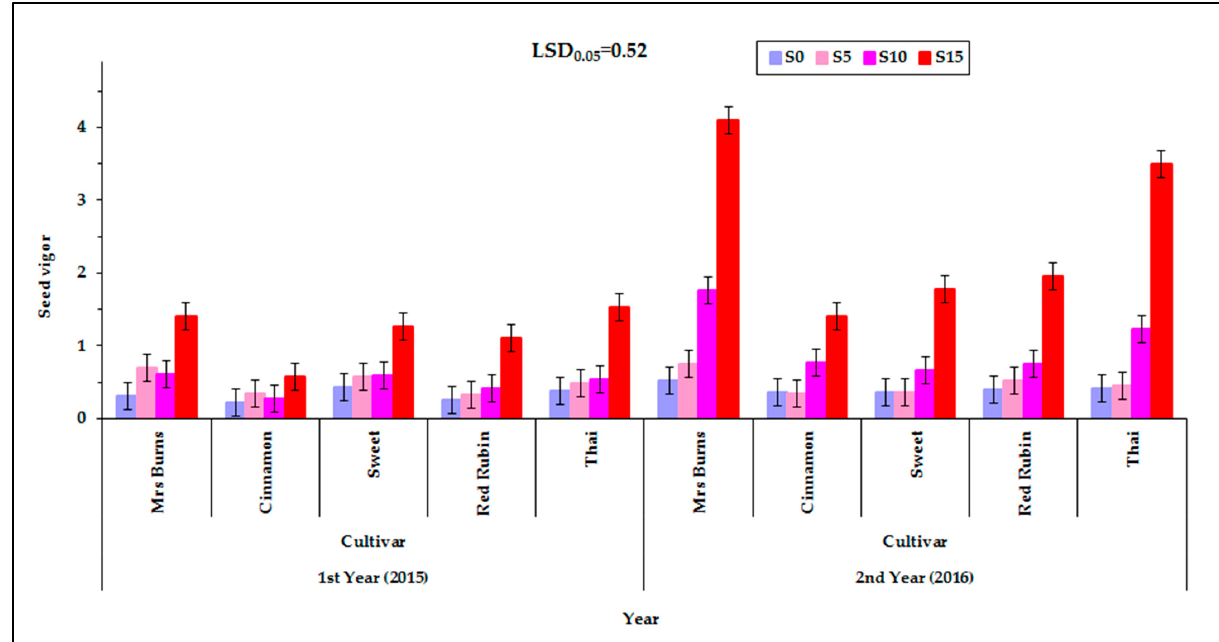
Figure 10. Seed vigor of the five basil cultivars (“Mrs Burns”, “Cinnamon”, “Sweet”, “Red Rubin”, and “Thai”), at the four PEG concentrations (S 0 , S 5 , S 10 , and S 15 ) at the two years of experimentation. Data presented are estimated mean values averaged over the three irrigation levels. LSD is the least significant difference at the 0.05 significance level. Error bars correspond to the estimated common standard error of the mean values. Each mean value has been estimated utilizing n = 12 measurements. Figure S10 (see Supplementary Material) presents the observed mean values and the corresponding individual standard